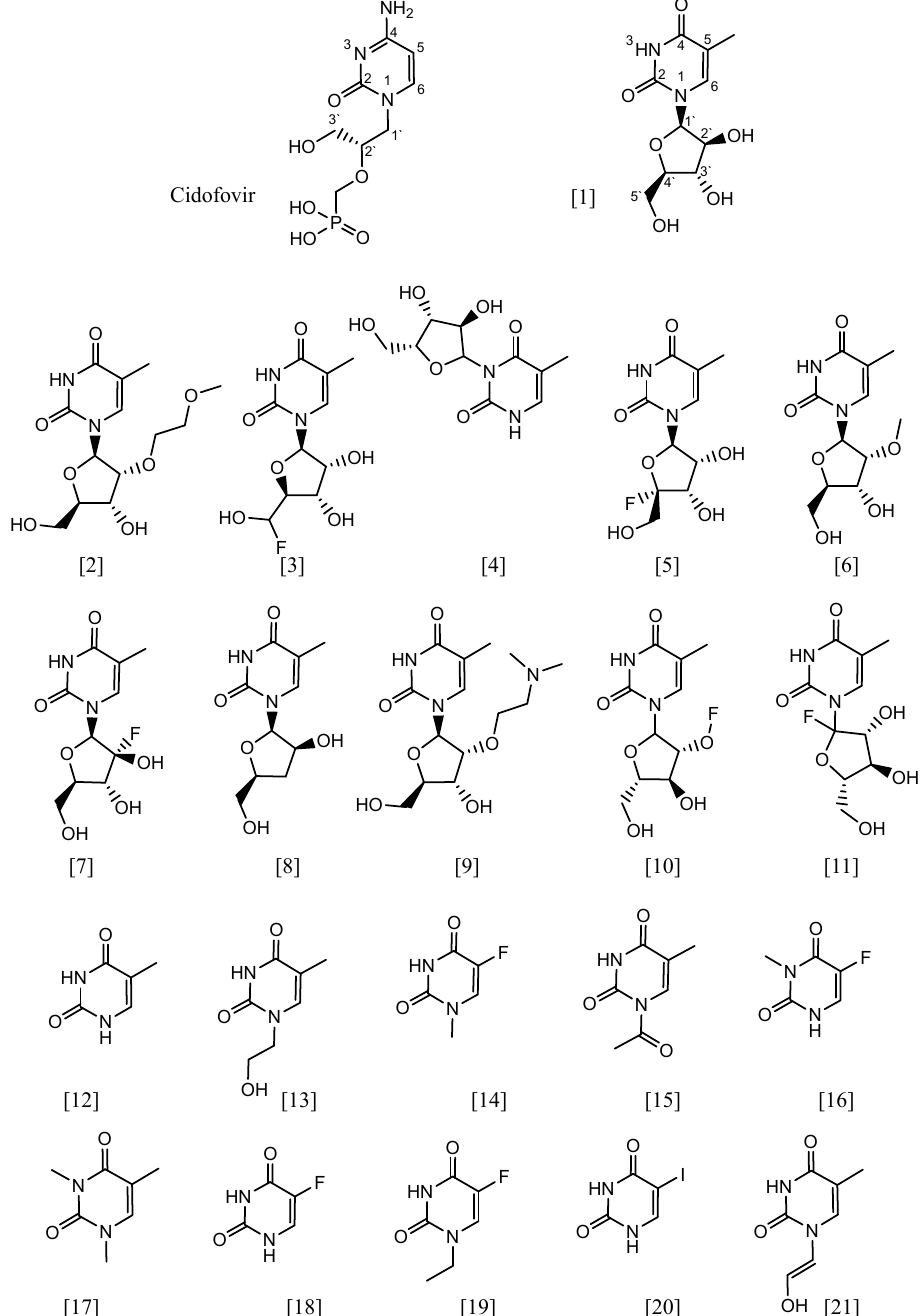
Figure 1. Chemical structures ( 1 – 21 ) were used in the study and taken from the PubChem database using the Tanimoto score of 97%.